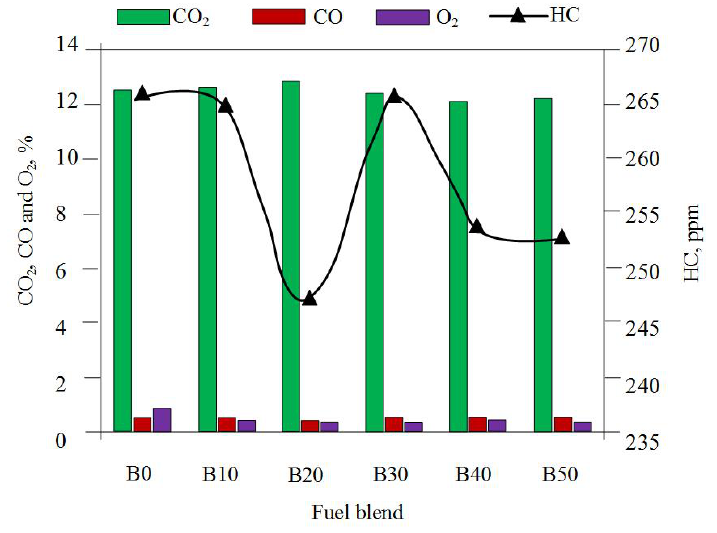
Fig. 4. Emission profile of combusted fuel